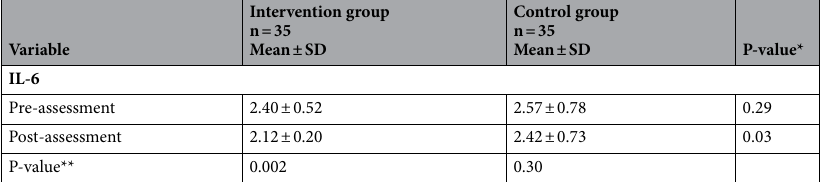
Table 4. Comparison of the serum levels of IL-6 (pg/mL) between intervention and control groups. IL-6: Interleukin 6, pg/mL (picograms per milliliter). *T-test was carried out for comparison of the groups. **Paired T-test was carried out for comparison of changes between the groups.